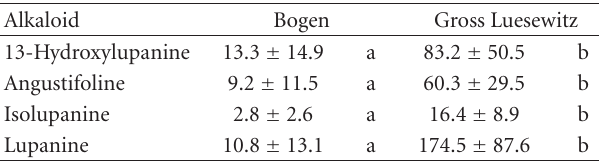
Table 3: Mean content ( ± SD) of alkaloids in di ff erent cultivars of Lupinus angustifolius at di ff erent locations (2004 and 2005). Alkaloid Bogen Gross Luesewitz 13-Hydroxylupanine 13.3 ± 14.9 a 83.2 ± 50.5 b Angustifoline 9.2 ± 11.5 a 60.3 ± 29.5 b Isolupanine 2.8 ± 2.6 a 16.4 ± 8.9 b Lupanine 10.8 ± 13.1 a 174.5 ± 87.6 b